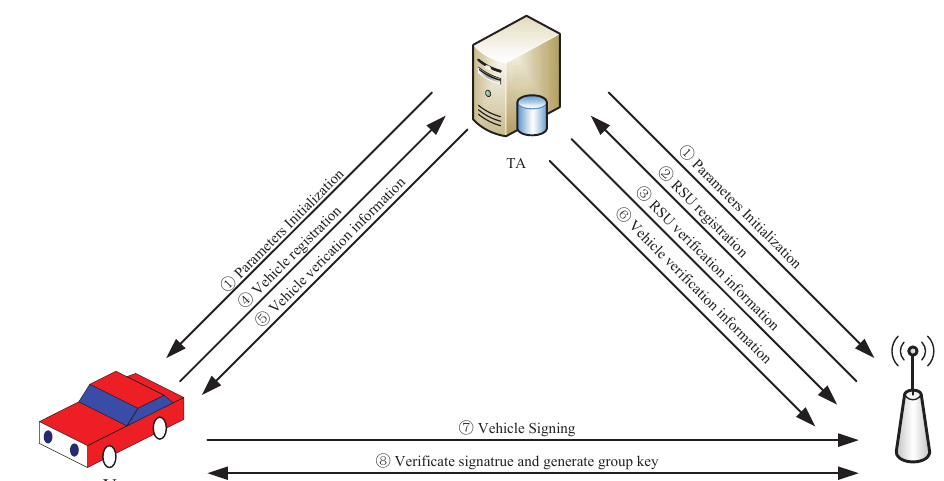
Figure 2. The process of group key agreement.